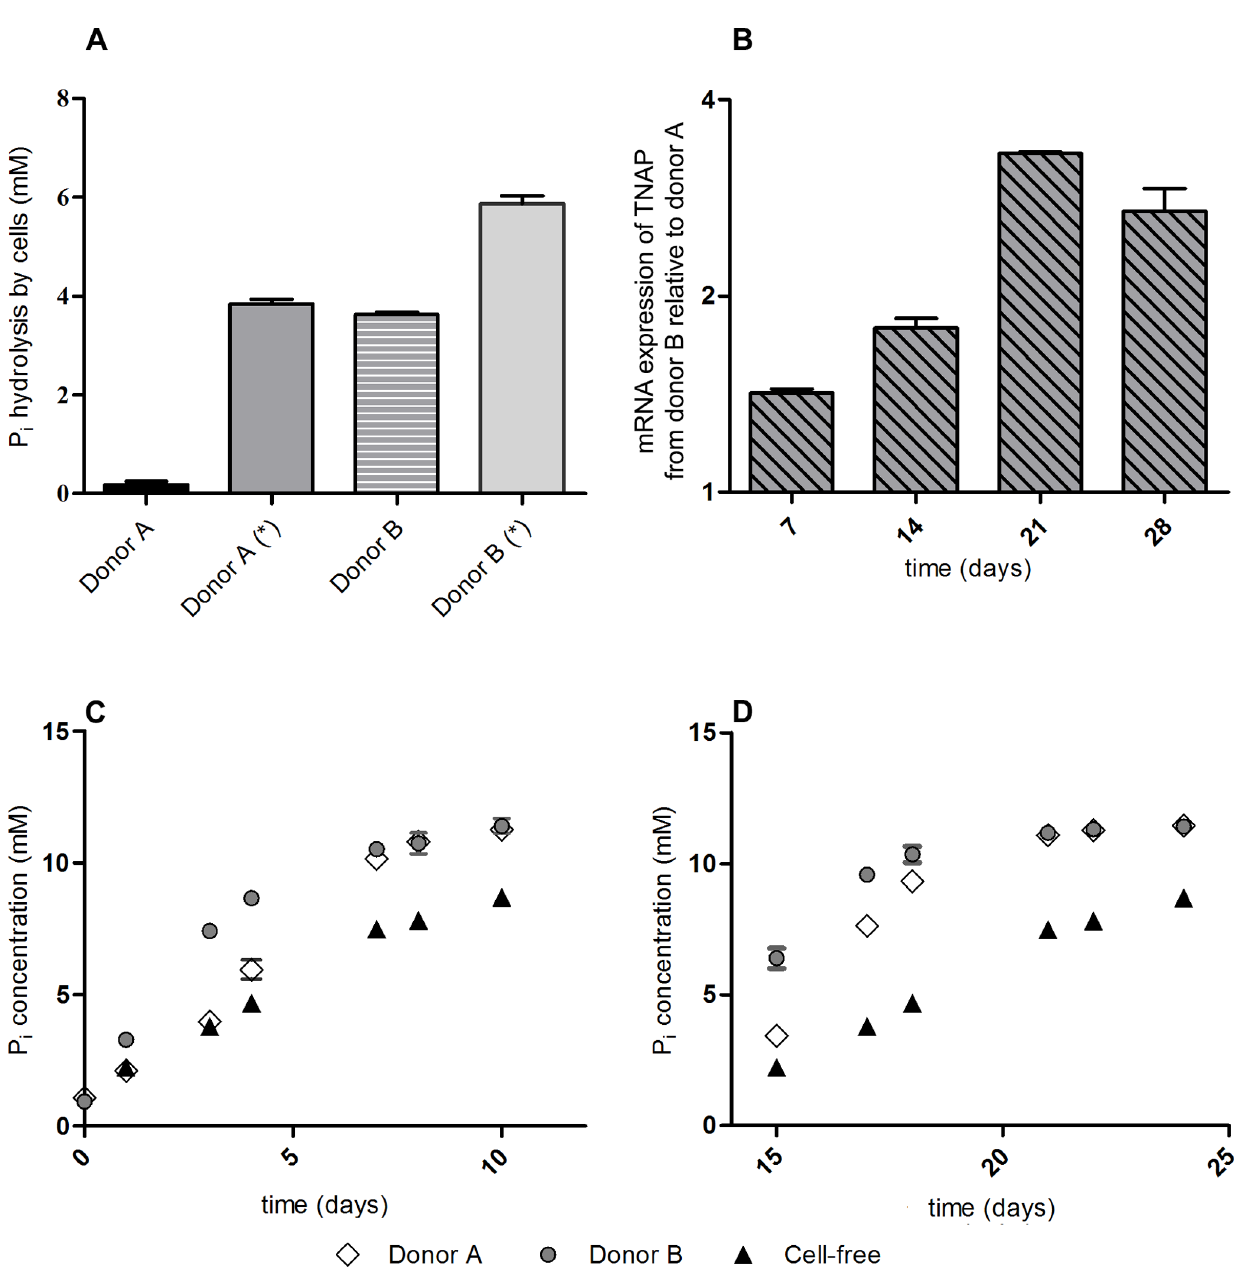
Figure 2. b GP hydrolysis and TNAP mRNA expression. A. Differences in phosphate hydrolysis over 3 days depending on the donor cells with (*) or without 14 days of pre-incubation in osteo-inductive medium containing 10 mM b GP with normal changes of medium. The free P i concentration generated under cell-free conditions has been subtracted. Plotted is mean 6 SD. B. Real-time PCR mRNA expression data of TNAP for donor B relative to donor A on days 7, 14, 21 and 28 of the osteogenic differentiation. C. Stability of b GP in the medium with cells and under cell-free conditions (no changes of medium) without pre-incubation of cells. Data plotted as mean 6 SD (small SD not visible) D. Stability of b GP in the medium with cells and under cell-free conditions (no changes of medium) with 14 days of pre-incubation in osteo-inductive medium containing 10 mM b GP with normal changes of medium.